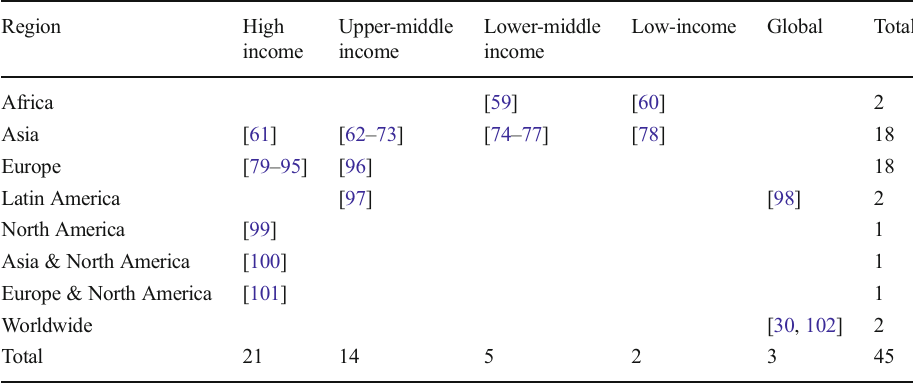
Table 1 Publications per region